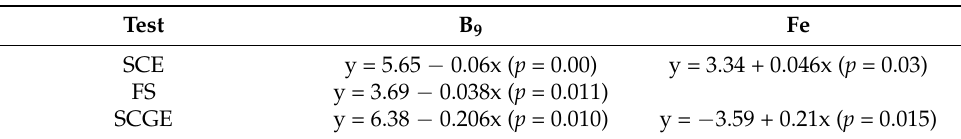
Table 4. Regression equations describing the relationship between levels of damage and the content of vitamin B9 and